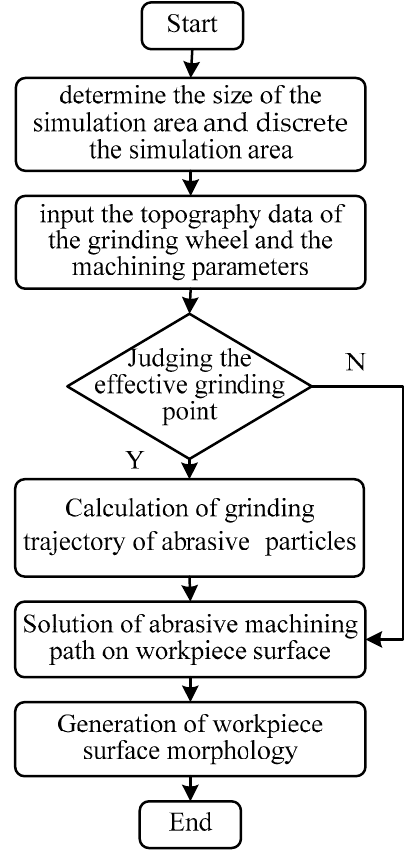
Figure 9. Simulation flow chart of grinding surface topography.